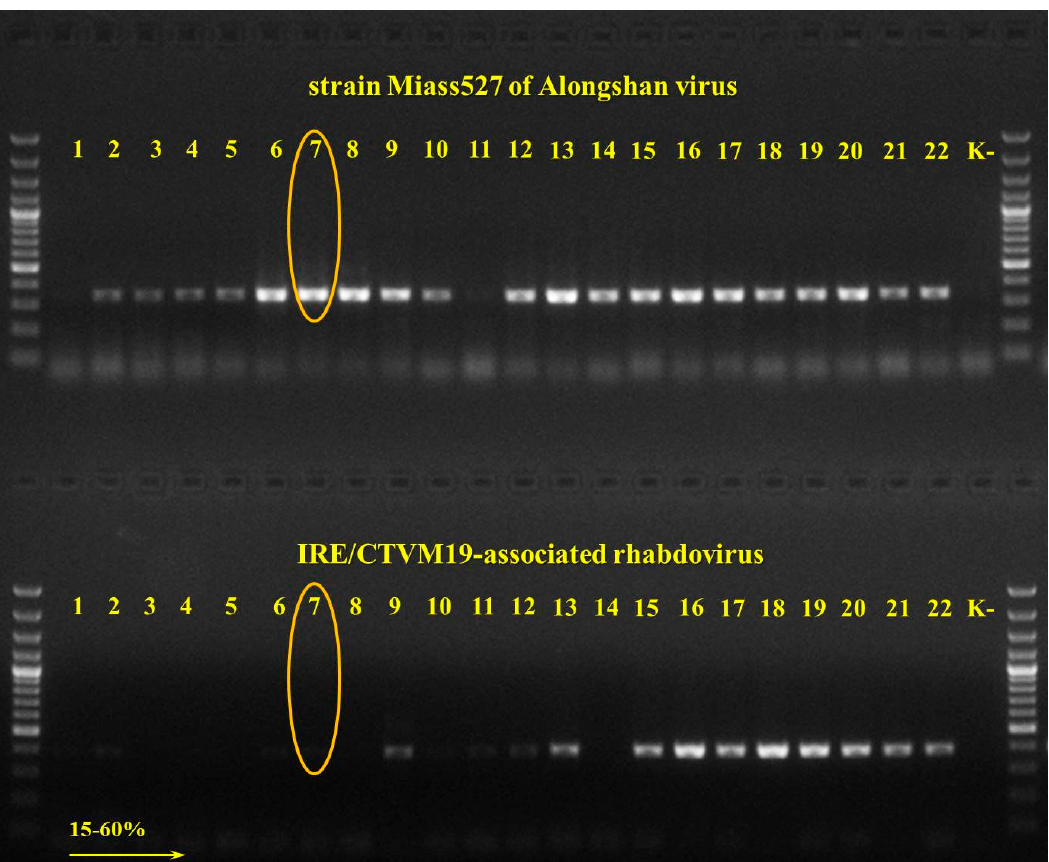
Figure 3. Electrophoresis of PCR fragments of sucrose density gradient fractions of Alongshan virus-infected IRE / CTVM19 cells. We separated Alongshan virus (ALSV) strain Miass527 and IRE / CTVM19-associated rhabdovirus strain BSLab by sucrose density gradient centrifugation to identify the fraction with the largest amount of ALSV RNA. Viral genomic cDNA was amplified by PCR using specific primers for ALSV (Miass_gly_3F and Miass_gly_3R) and IRE / CTVM19-associated rhabdovirus (Rhabdo _L_1F and Rhabdo_L_1R). Fraction #7 was selected for transmission electron microscopy. ##1–22—gradient fractions, K- negative